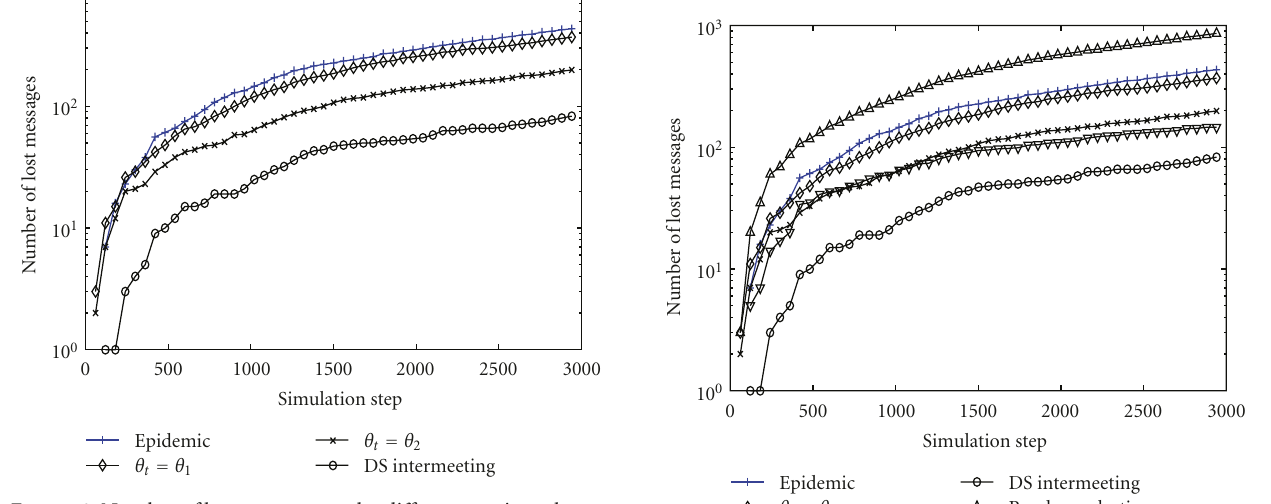
Figure 8: Number of lost messages under di ff erent routing schemes and di ff erent threshold values.